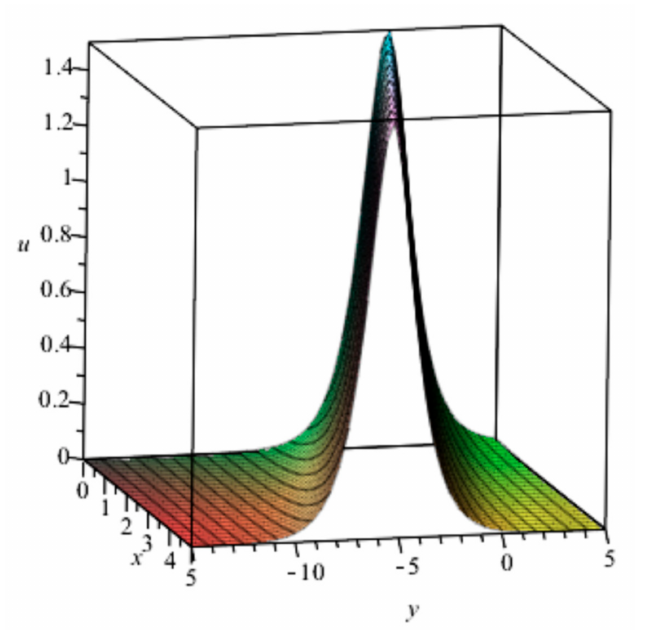
Figure 3. Solution locations for β = 0.9.